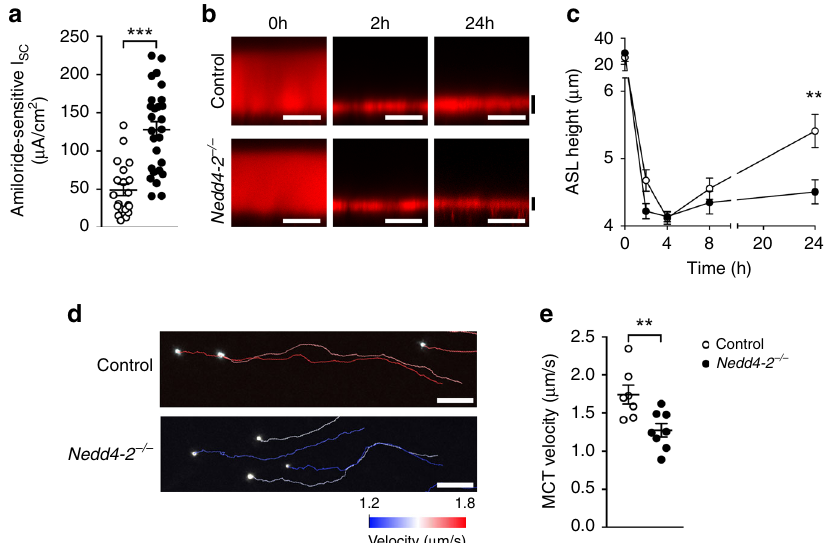
Fig. 4 Conditional deletion of Nedd4-2 in airway epithelial cells causes increased ENaC activity, reduced airway surface liquid (ASL) height and impaired mucociliary transport. a Amiloride-sensitive short circuit current ( I sc ) in freshly excised airway tissues of conditional Nedd4-2 − / − and control mice (control, n = 20 mice; conditional Nedd4-2 − / − , n = 27 mice) induced with doxycycline for 2 weeks. b , c Confocal images of ASL height ( b ) and summary of measurements ( c ) at baseline and 2, 4, 8, and 24 h after application of rhodamine dextran to primary murine airway epithelial cultures from conditional Nedd4-2 − / − mice and littermate controls induced with doxycycline for 2 weeks ( n = 3 independent experiments performed in triplicates). Scale bars, 15 µ m. d , e Mucociliary transport (MCT) velocity was determined from transport rates of fl uorescent beads added on the surface of primary murine airway epithelial cultures. Representative bead tracks that visualize MCT velocity ( d ) and summary of measurements ( e ) in primary cultures from conditional Nedd4-2 − / − mice and littermate controls ( n = 3 independent experiments). Scale bars, 50 µ m. ** P < 0.01, *** P < 0.001. Statistical analysis in a was performed with two-tailed Mann – Whitney test and in c , e with unpaired two-tailed t test. Data are shown as mean ± S.E.M. Source data are provided in the Source Data fi